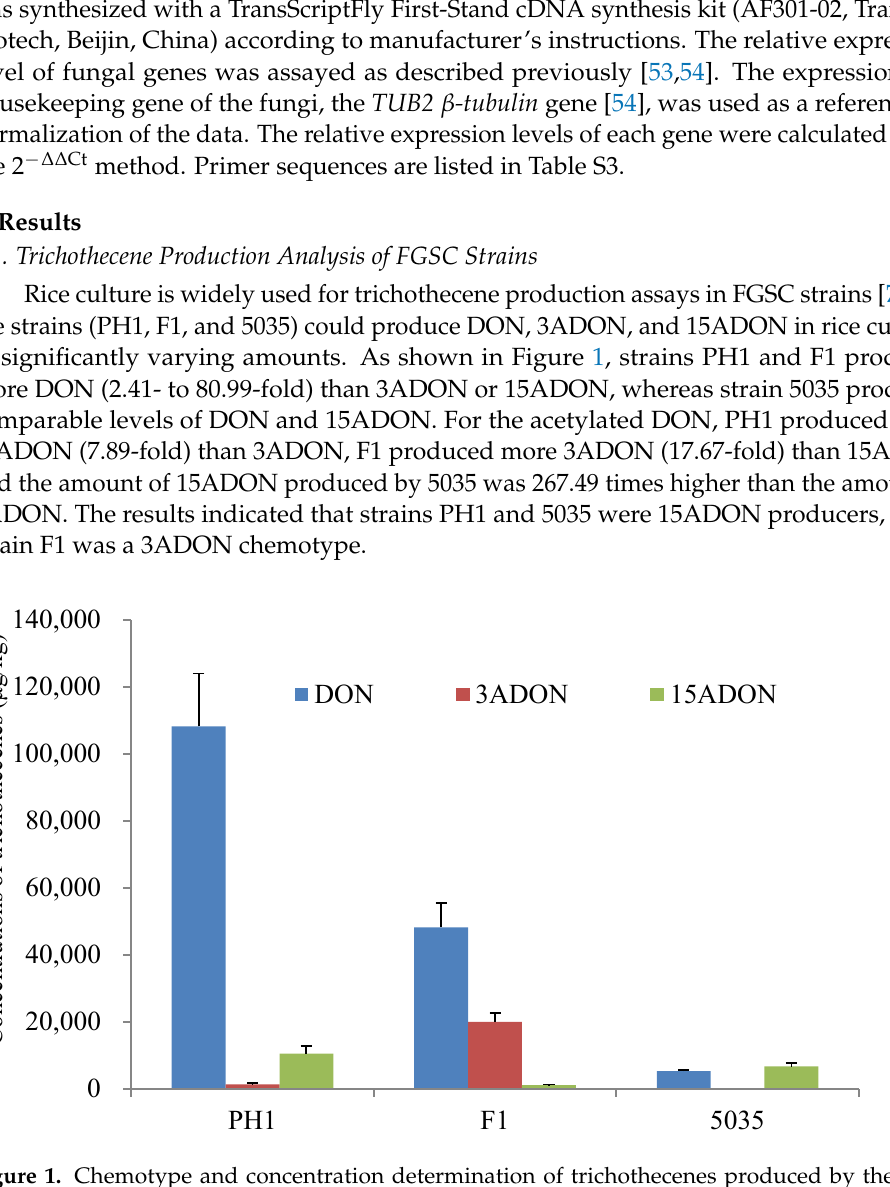
Figure 1. Chemotype and concentration determination of trichothecenes produced by the three Fusarium strains cultured in rice media.